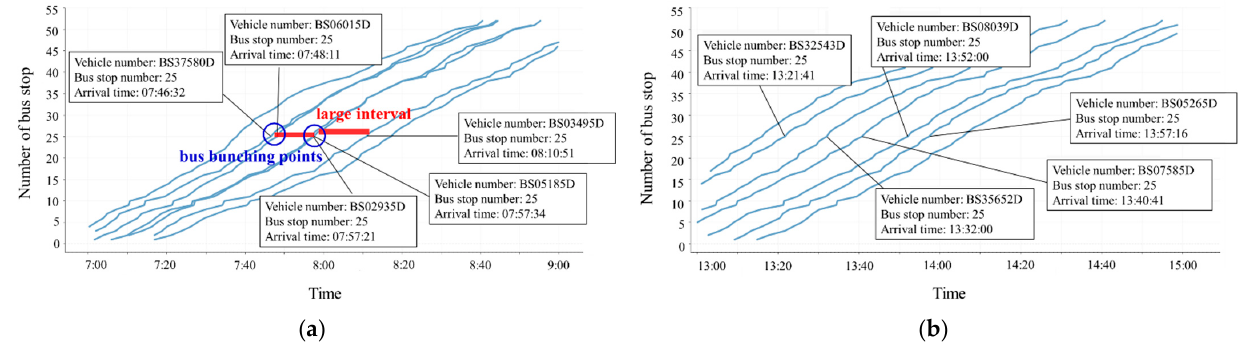
Figure 4. The process of bus operation during peak time and off-peak time: ( a ) During peak time